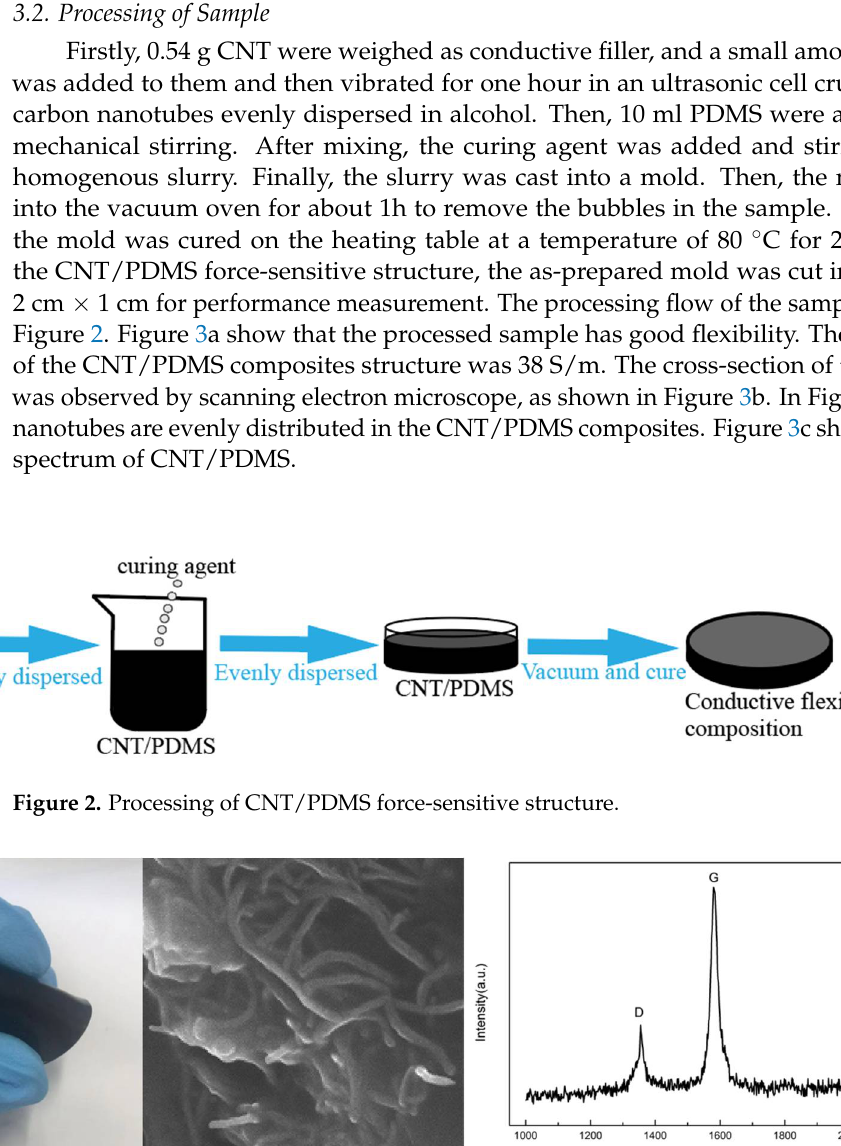
Figure 1. The equivalent circuit of CNT/PDMS force-sensitivity test ( a , b ) DC condition ( c , d ) AC condition.